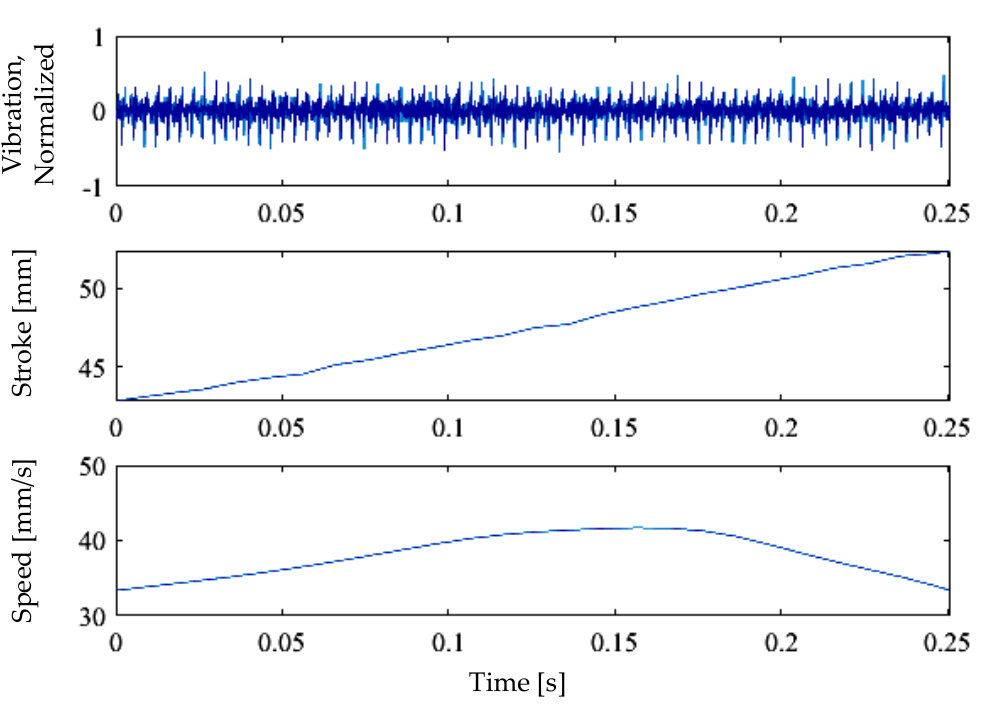
Figure 9. Measurements from dataset ID 2 and spall ID 1.